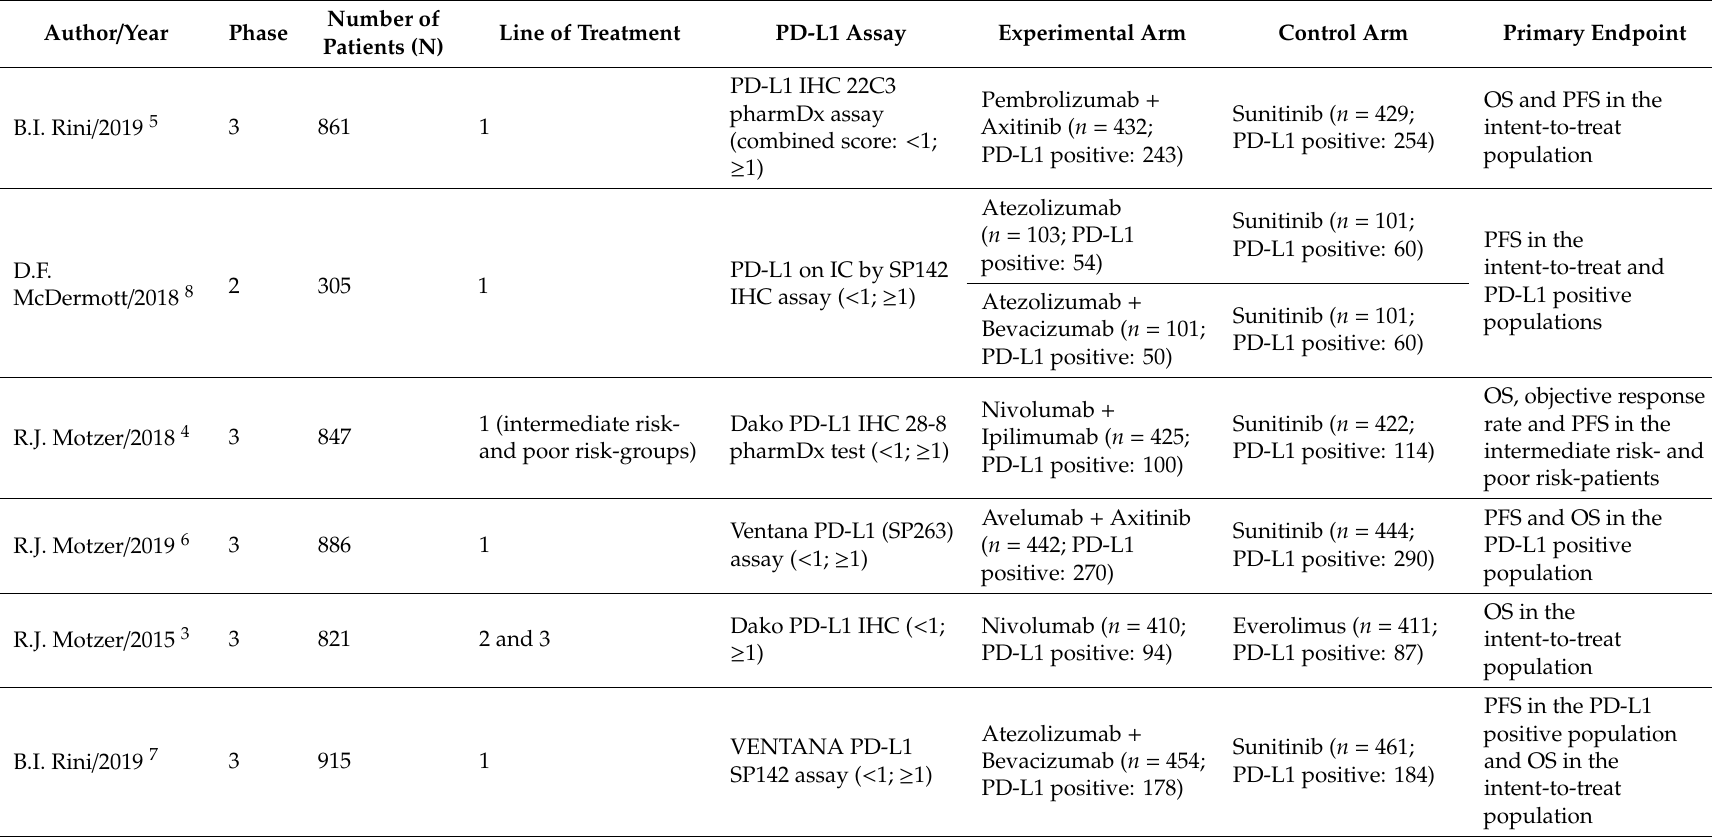
Table 1. Summary of randomized clinical trials included in the